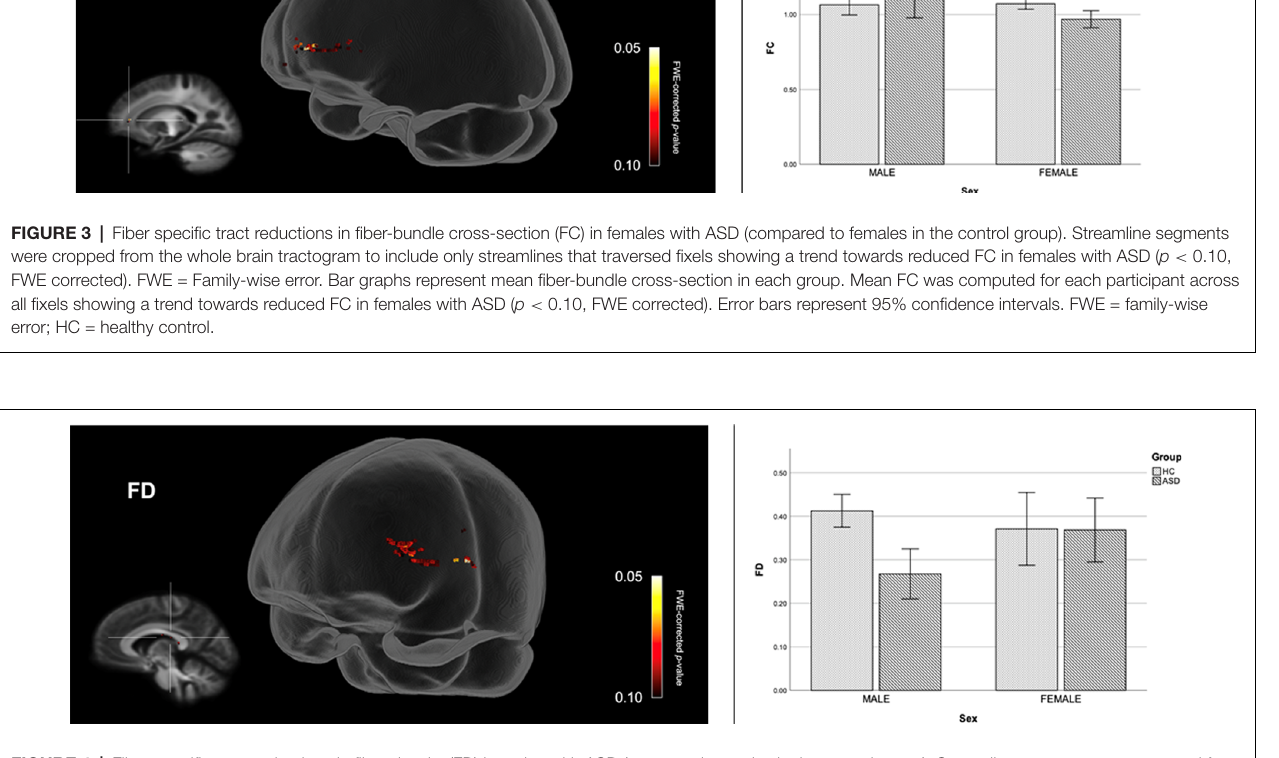
FIGURE 4 | Fiber specific tract reductions in fiber density (FD) in males with ASD (compared to males in the control group). Streamline segments were cropped from the whole brain tractogram to include only streamlines that traversed fixels showing a trend towards reduced FD in males with ASD ( p < 0.10, FWE corrected). FWE = Family-wise error. Bar graphs represent mean FD in each group. Mean FD was computed for each participant across all fixels showing a trend towards reduced FD in males with ASD ( p < 0.10, FWE corrected). Error bars represent 95% confidence intervals. FWE = family-wise error; HC = healthy